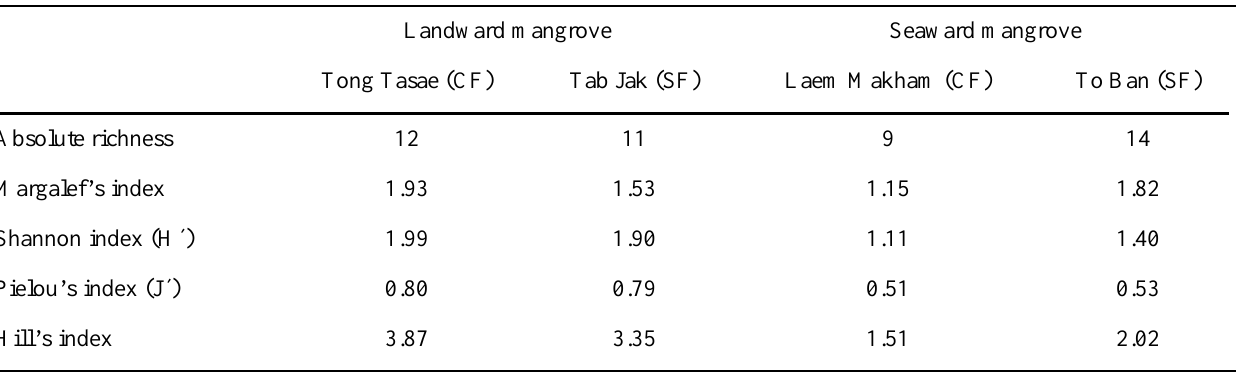
Table 6. Species diversity and evenness of mangrove trees of community-managed (CF) and state-managed (SF) mangrove forests in Trang, southern